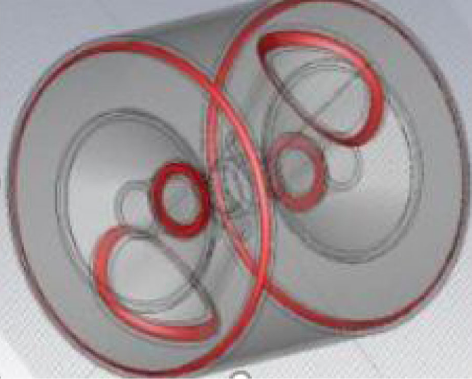
FIG. 28. One-eighth cavity structure used for the multipacting simulations.FIG. 26. The particle source defined in the zones of multi-